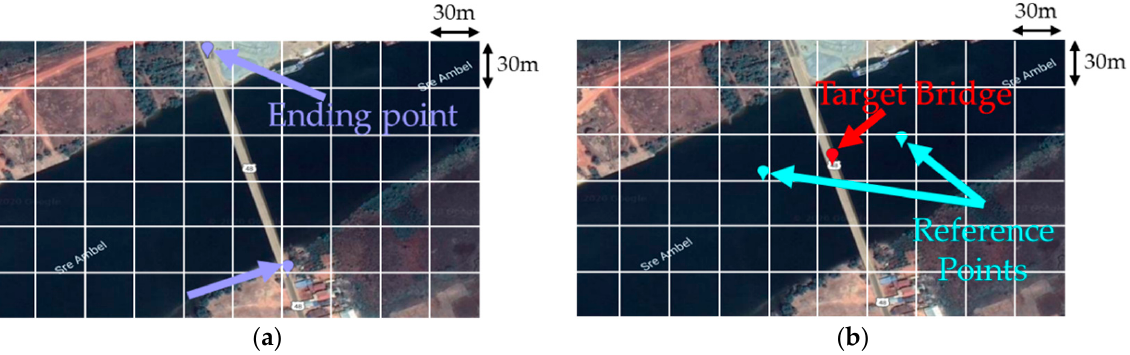
Figure 6. ( a ) Inputting the bridge location (from end to end of the bridge); ( b ) bridge location using the end points from Figure 7a and reference points.